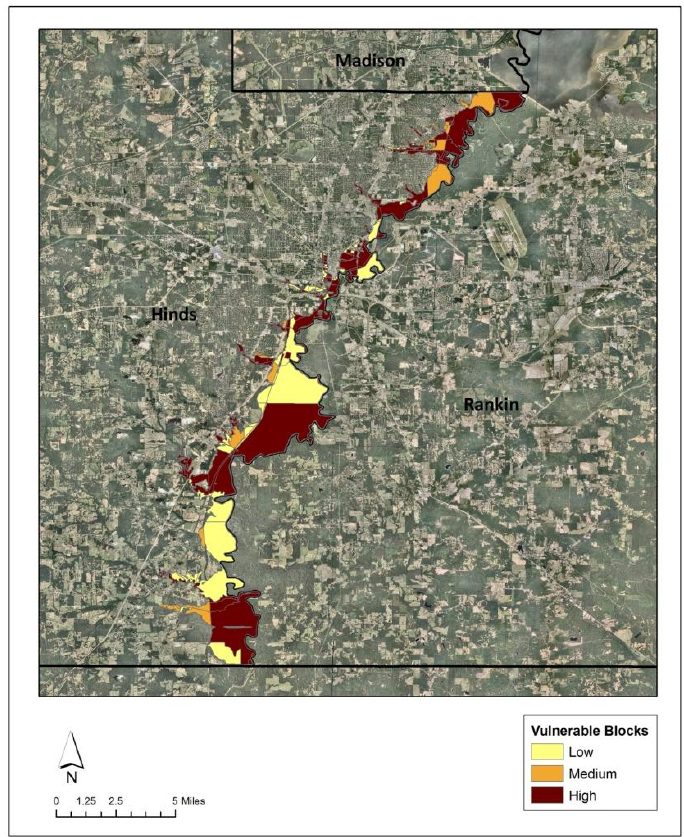
Figure 23. Levels of vulnerability at a census block level in Hinds